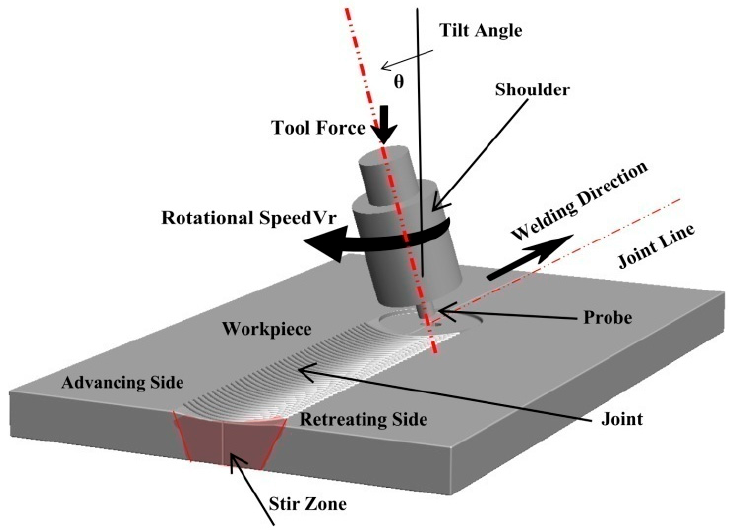
Figure 3. A schematic of the FSW process, indicates the process’s main characteristic features. The FSW tool is shown with the exit hole just below the tool after extraction.